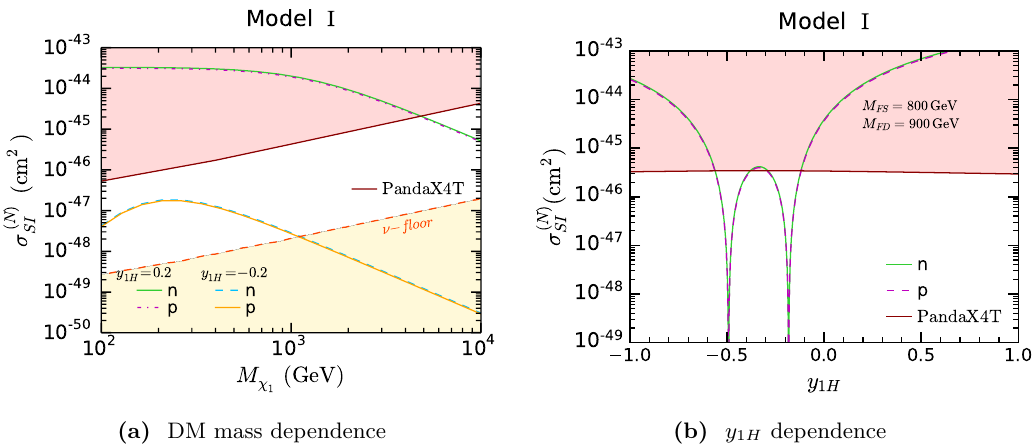
Figure 3. The DM-nucleon SI scattering cross sections as functions of (a) the DM mass M χ (b) y 1 H . The rest of the parameters are fixed as per in figure 2. The red shaded area is excluded by the PandaX4T experiment [171] and the yellow shaded region corresponds to the neutrino floor [172].